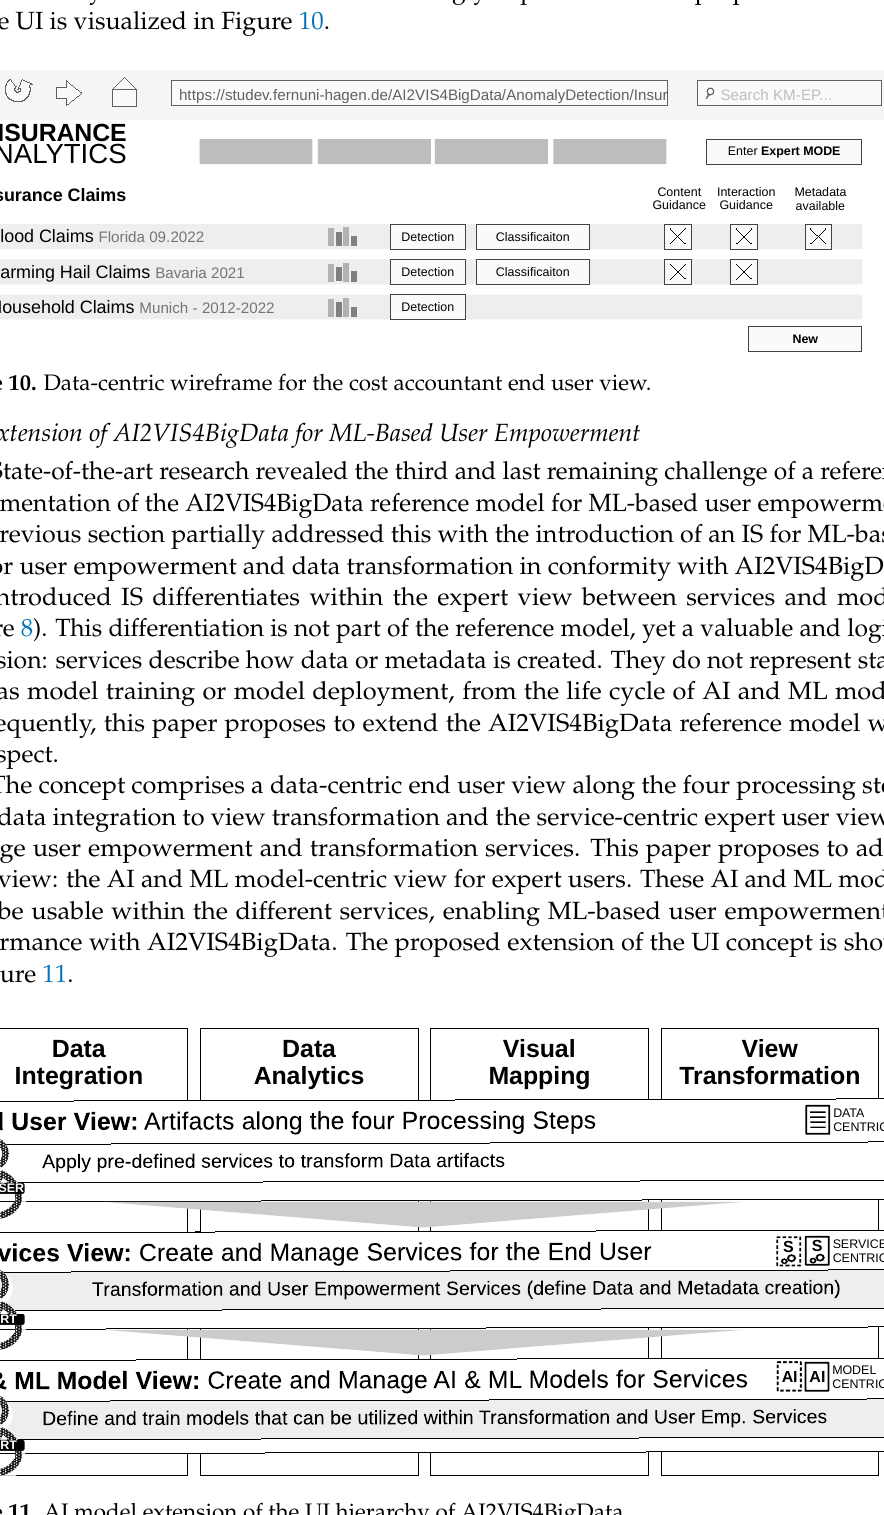
Figure 11. AI model extension of the UI hierarchy of